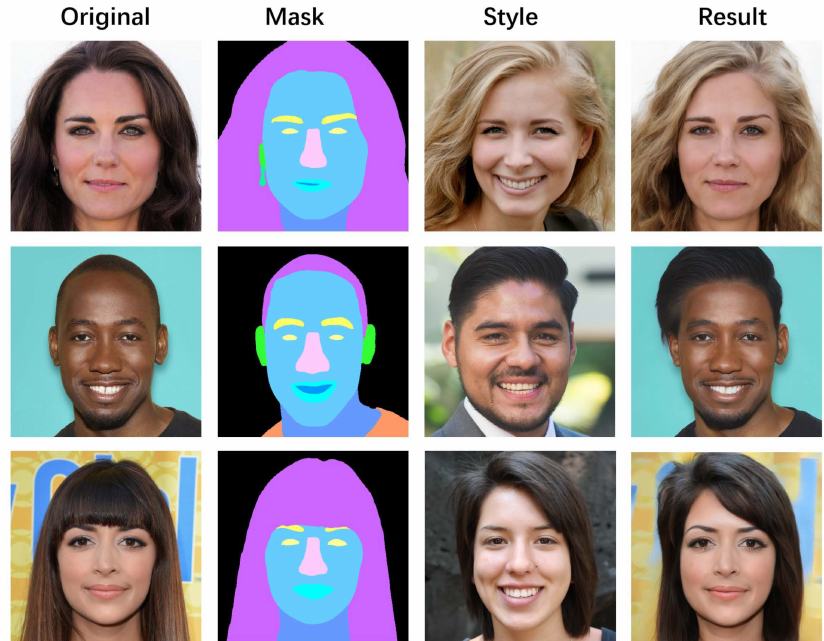
Figure 6. Examples of new hairstyles generated by the FTGH network.